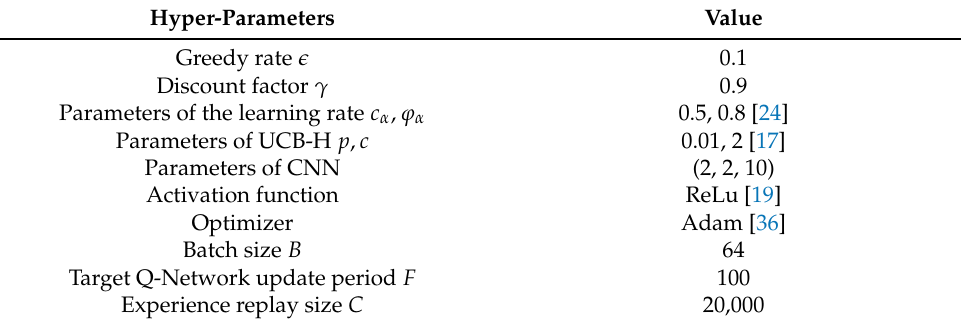
Table 2. Hyperparameters of the RL